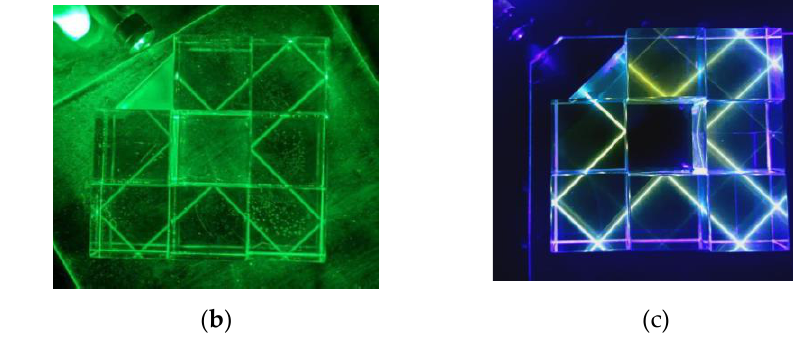
Figure 5. Wavelength-independent beam trajectory. Laser beams of RGB-colors pass the same trajectory through a TPhTI made of seven prism resonators: ( a ) red 650 nm, ( b ) green 532 nm, and ( c ) blue 405 nm.